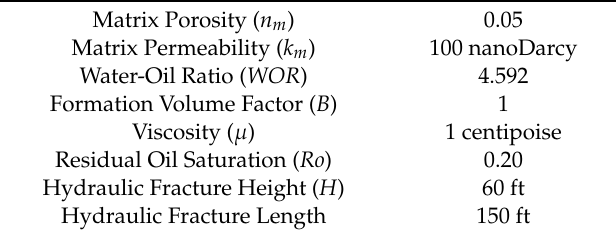
Table A1. Reservoir parameters used for modelling.